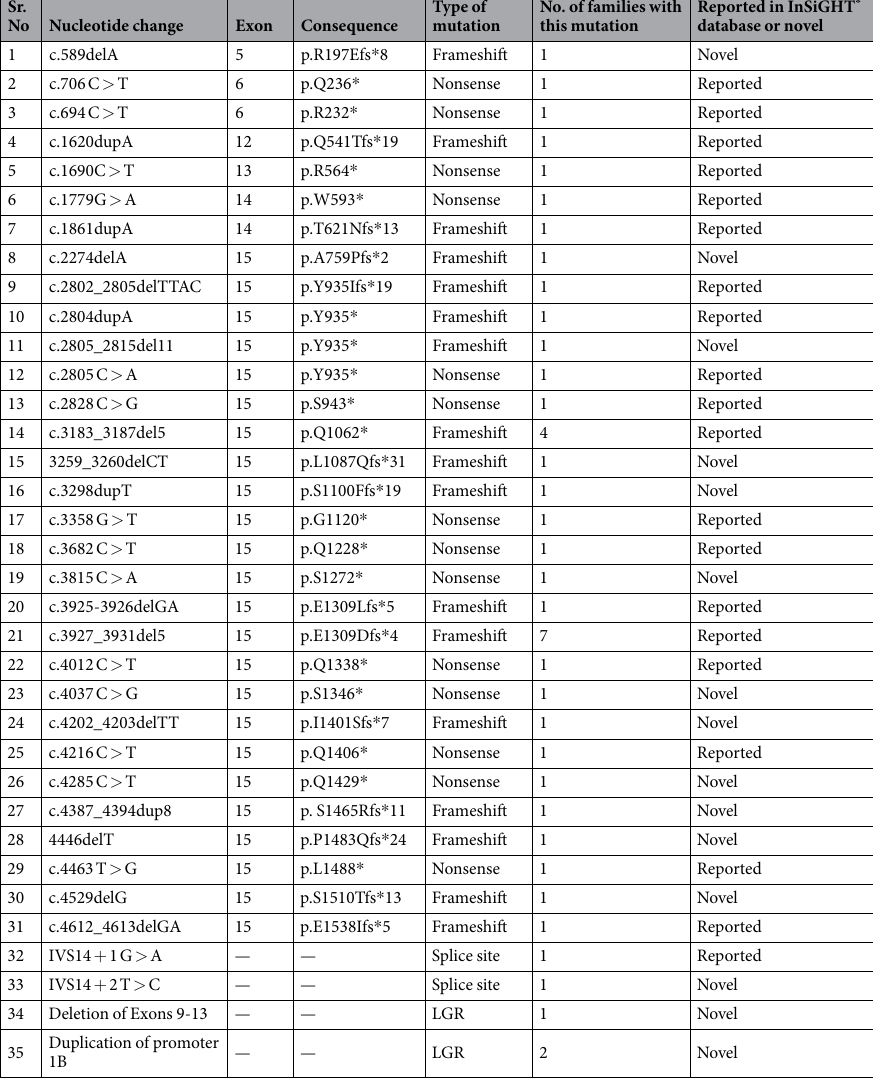
Table 1. Spectrum of APC mutations in Indian FAP